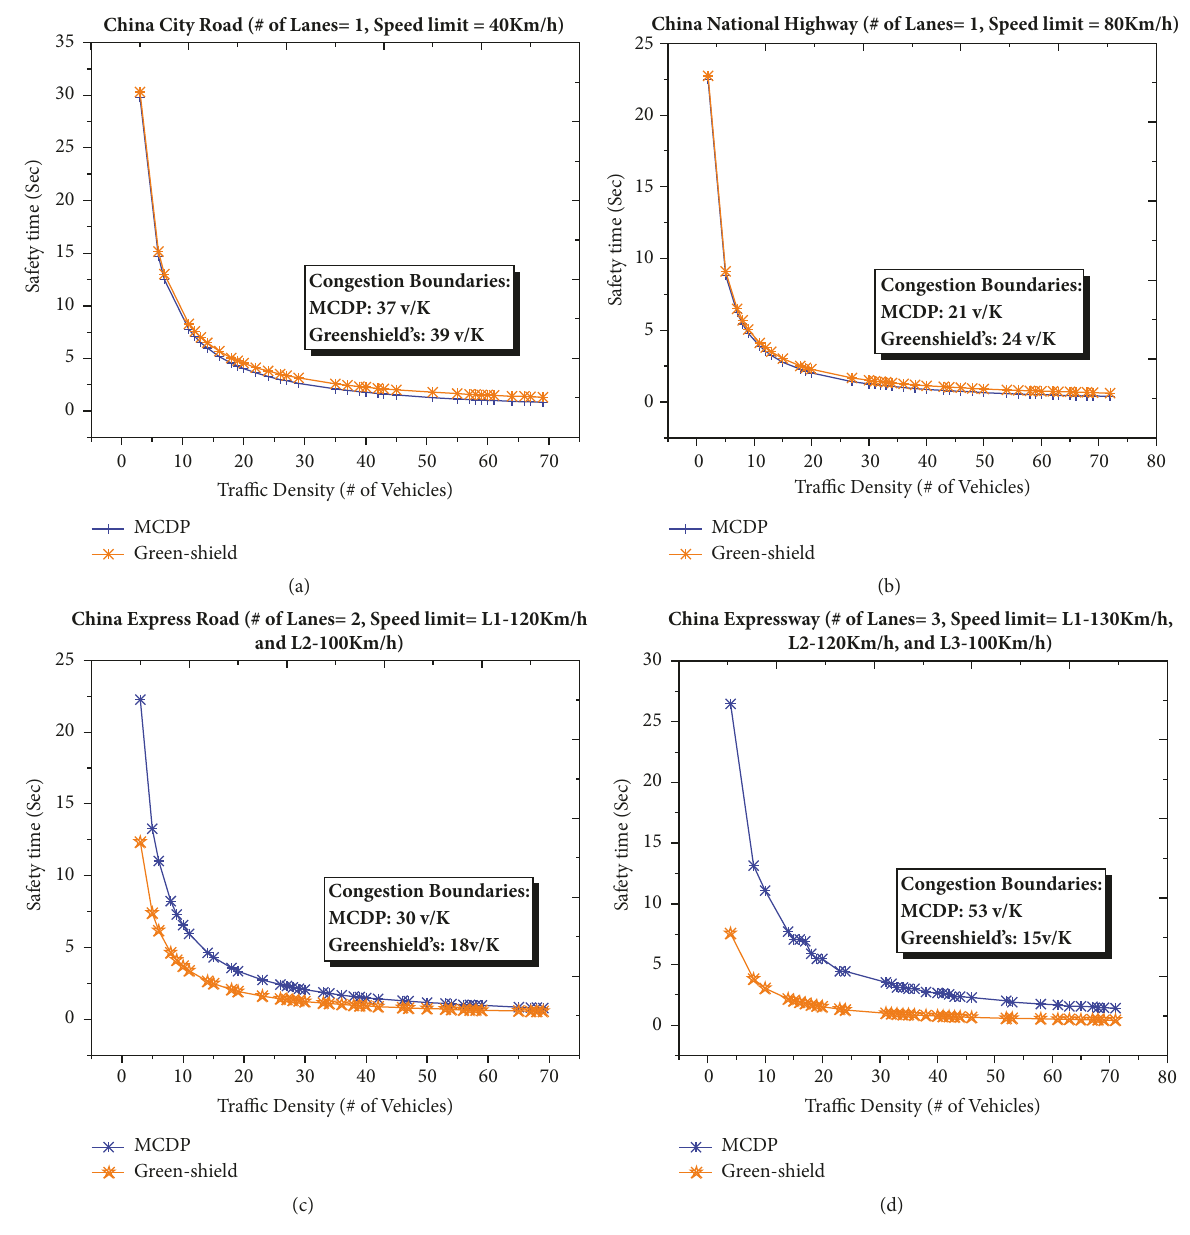
Figure 4: Congestion analysis in different single and multilane Chinese highways (DSRC Rang = 1000m, car size = 5m, bus size = 10m, and safety time threshold = 2